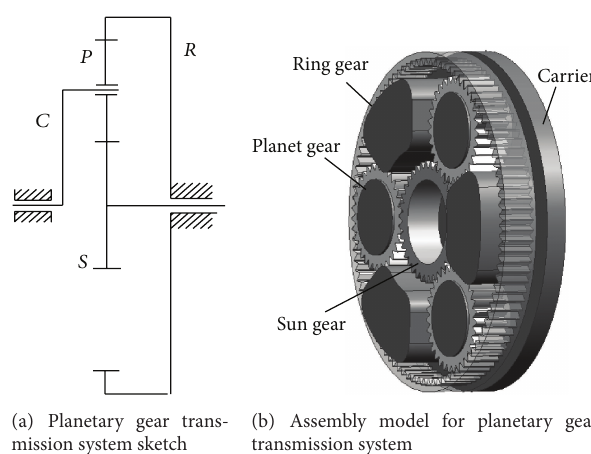
Figure 1: The planetary gear transmission system sketch and three-dimensional model.